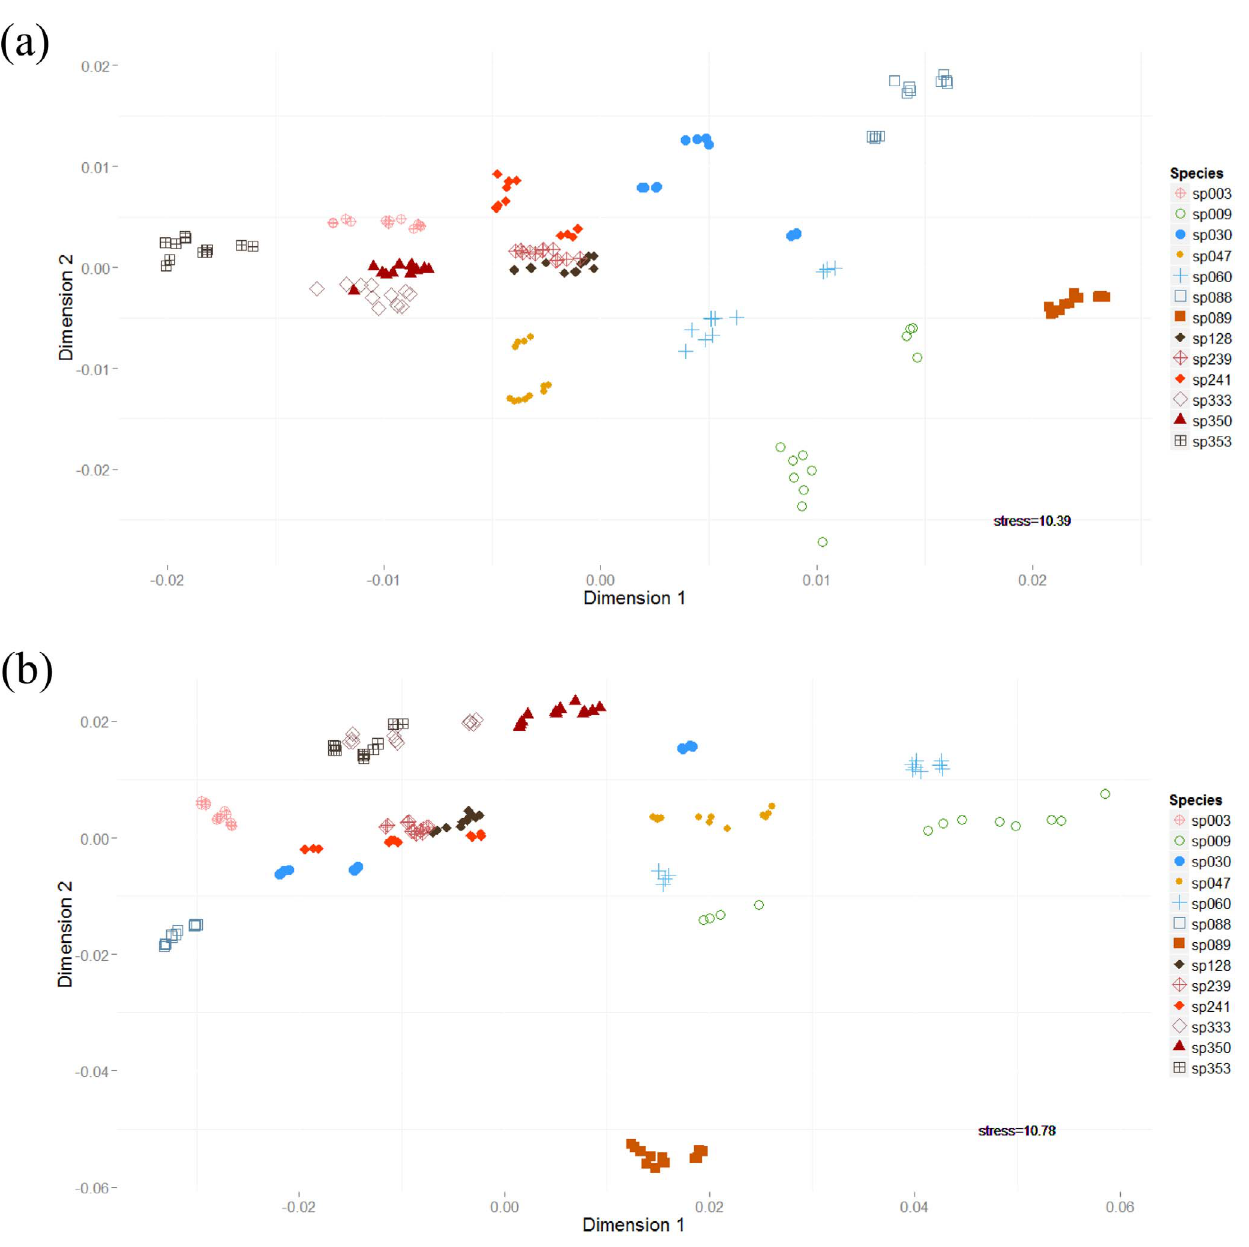
Fig. 4. Assessment of strain separation by NMDS of the 9-point first derivative spectra. Two different spectral window combinations are shown: (a) window III and V and (b) window IV and V. Strains of microalgae: Ankistrodesmus densus (003), Chlamydomonas clorastera (009), Desmodesmus communis (030), Selenastrum bibraianum (047), Coelastrum cf sphaericum (060), Scenedesmus ecornis (088), Micrasterias pinnatifida (089), Ankistrodesmus densus (128), Ankistrodesmus densus (239), Selenastrum bibraianum (241), Ankistrodesmus fusiformis (333), Selenastrum gracile (350) and Monoraphidium komarkovae